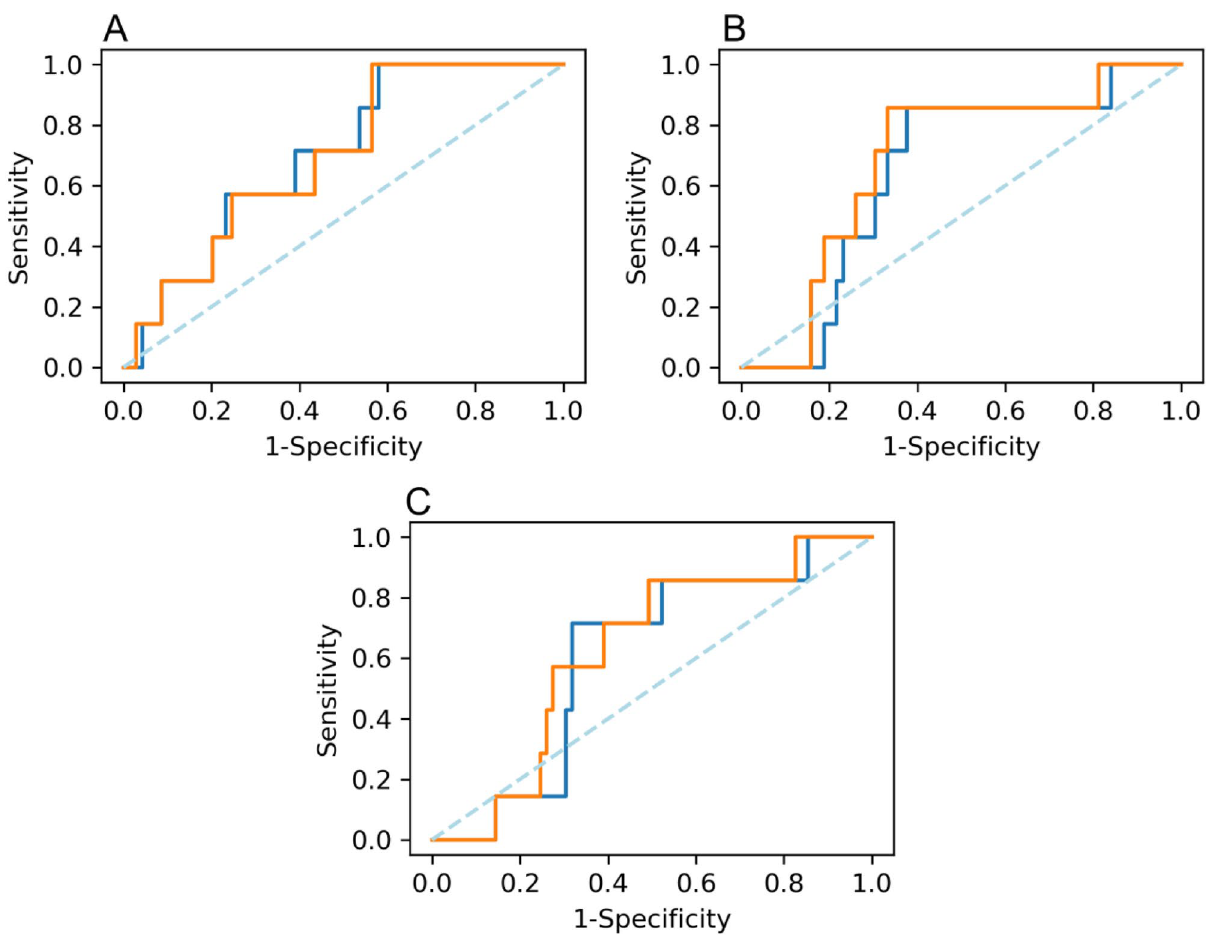
Figure 6. ROC curves comparing both software tools when using each threshold. Strong similarities are shown in 2.5 threshold. BI vs LIFEx 2.5 ( A ), BI vs LIFEx 41% ( B ), and BI vs LIFEx 50% ( C ). BI is displayed in blue and LIFEx in orange.